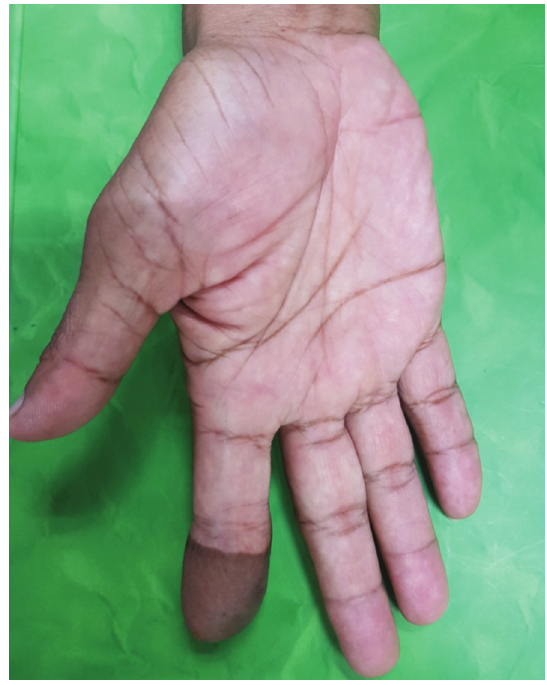
Volar view of index finger a year after surgery showing Fig. 3: significantly less bulky soft tissue as a result of debulking.